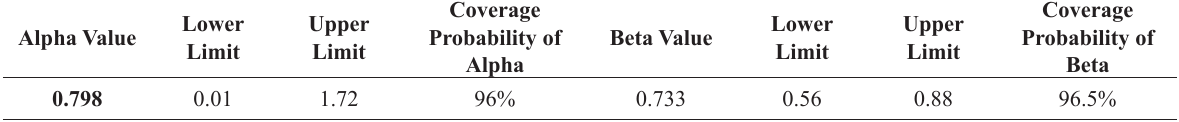
Table 2: Simulation Summary for Dataset.